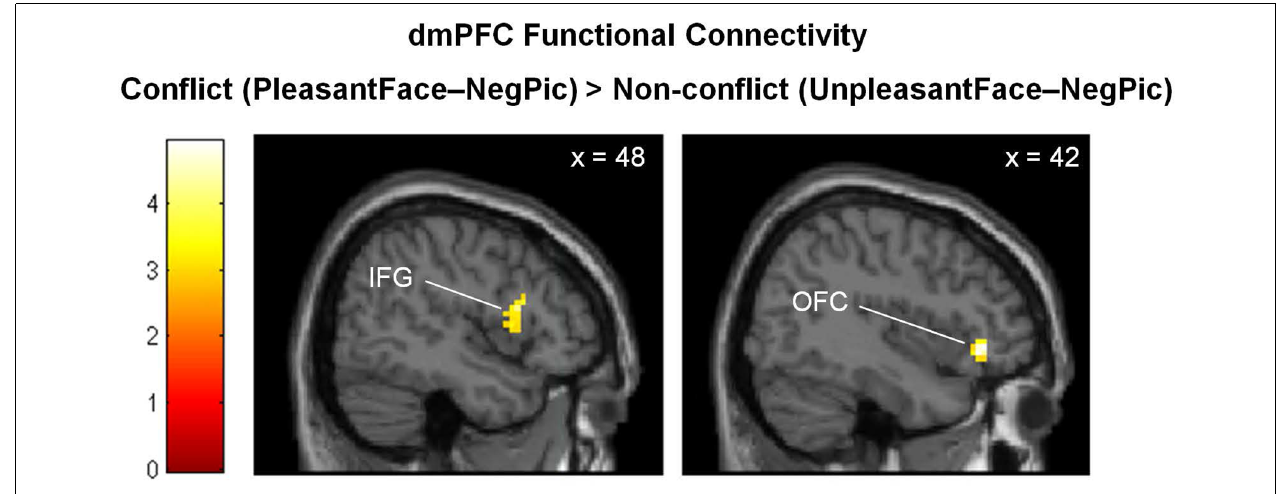
FIGURE 4 | Brain regions showing stronger functional connectivity with the dmPFC in the emotionally incongruent condition, as compared with the emotionally congruent condition. dmPFC, dorsomedial prefrontal cortex; IFG, inferior frontal gyrus; OFC, orbitofrontal cortex.